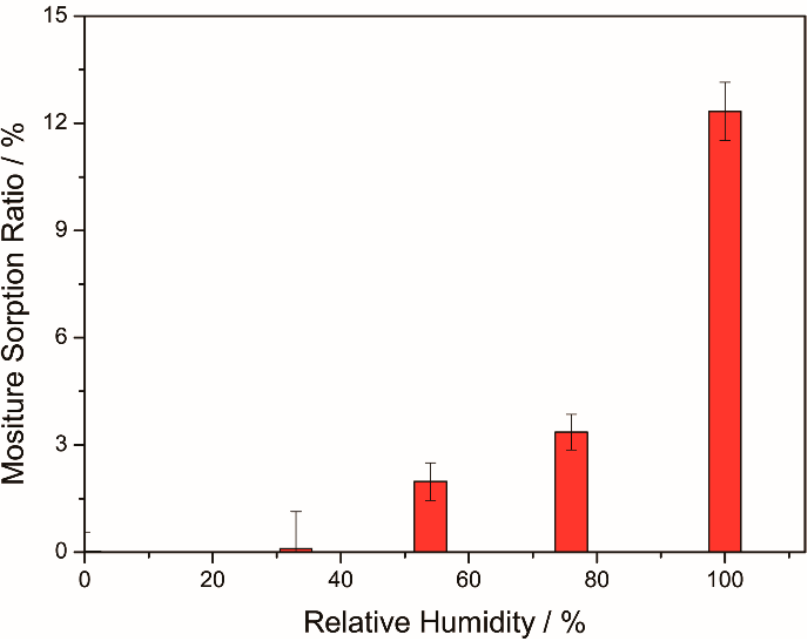
Figure 10. Moisture sorption ratio of the β -CD-TiO 2 /P(HEMA-co-BA) coating under different humidity conditions.